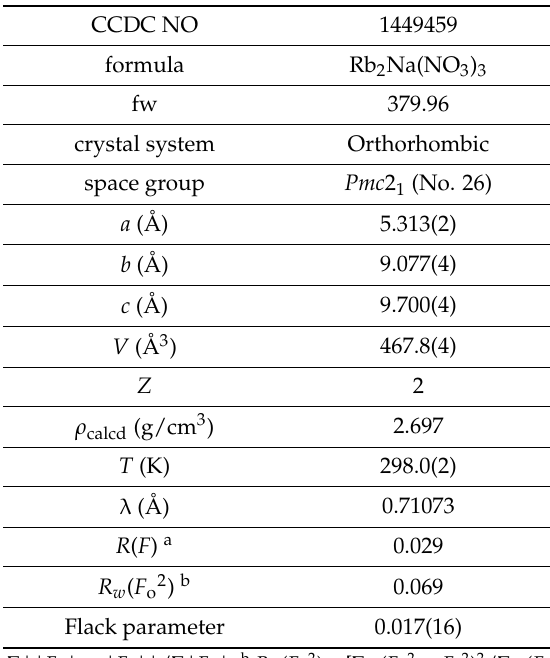
Table 2. Crystallographic Data for Rb 2 Na(NO 3 ) 3 .